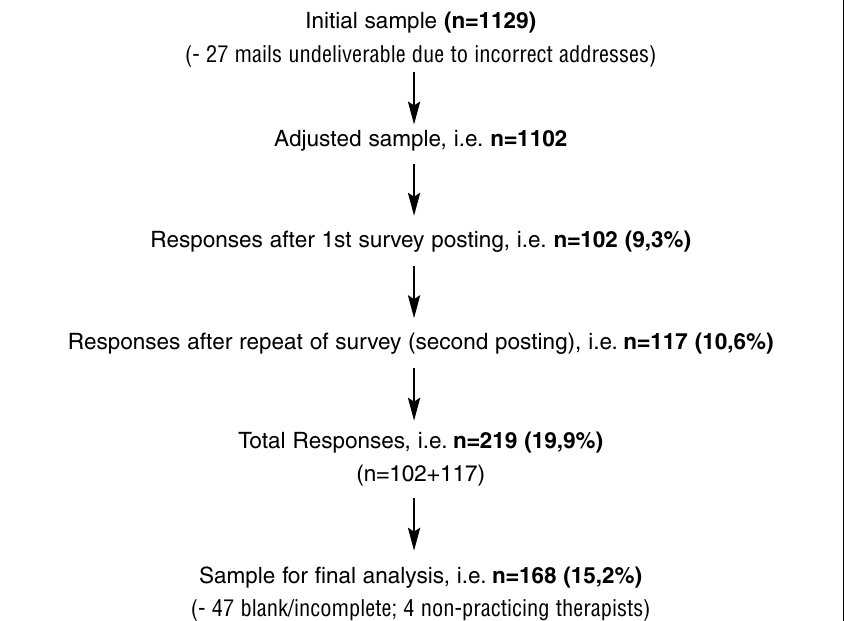
Figure 1: Response rate of survey to physiotherapists.